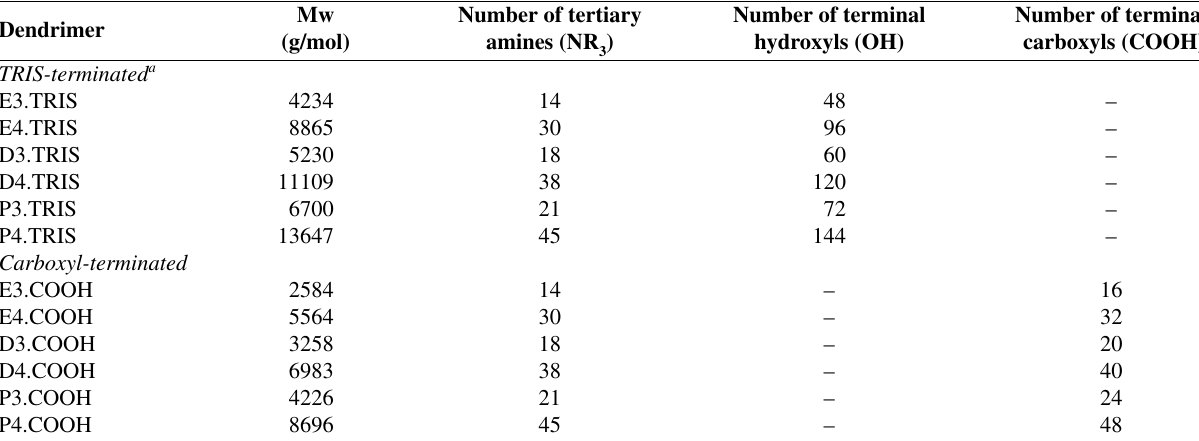
Table 2. The theoretical characteristic data of synthesized PAMAM dendrimers.